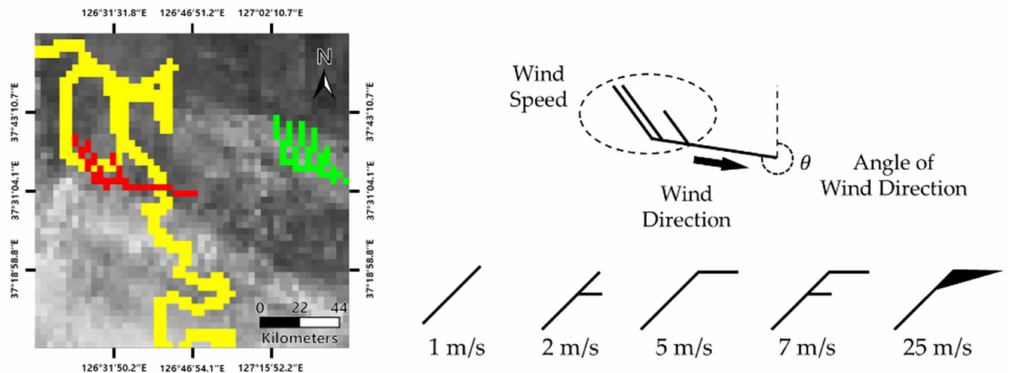
Figure 3. A standard station model for wind direction and